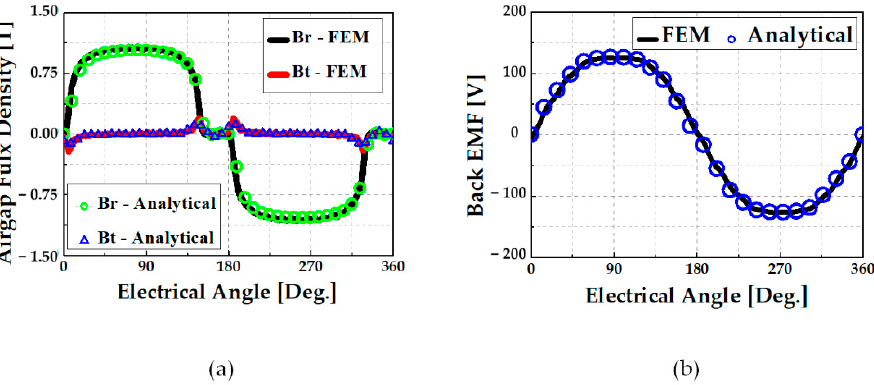
Figure 2. Results of the analytical method, and FEM: ( a ) air-gap flux density, and ( b )